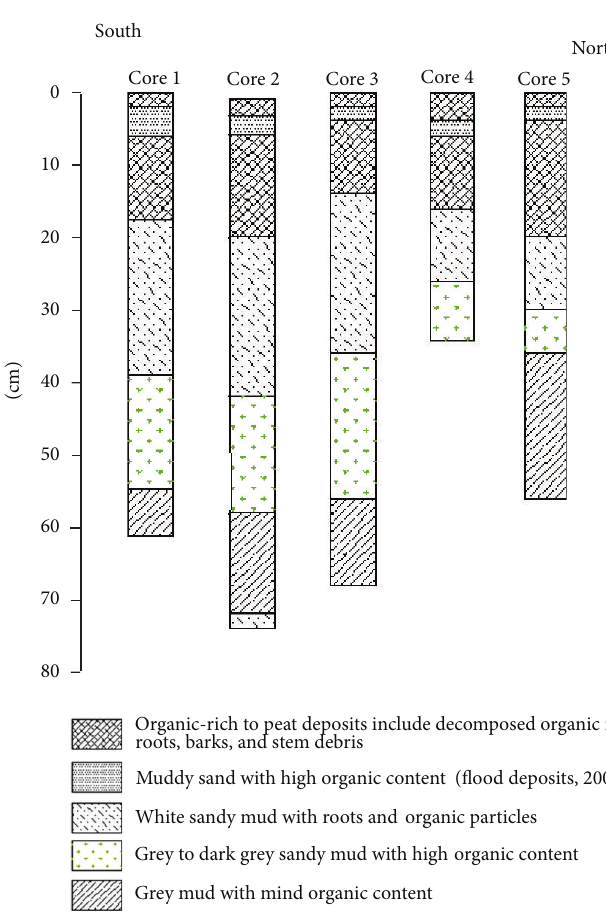
Figure 2: Bera Lake sediment stratigraphic